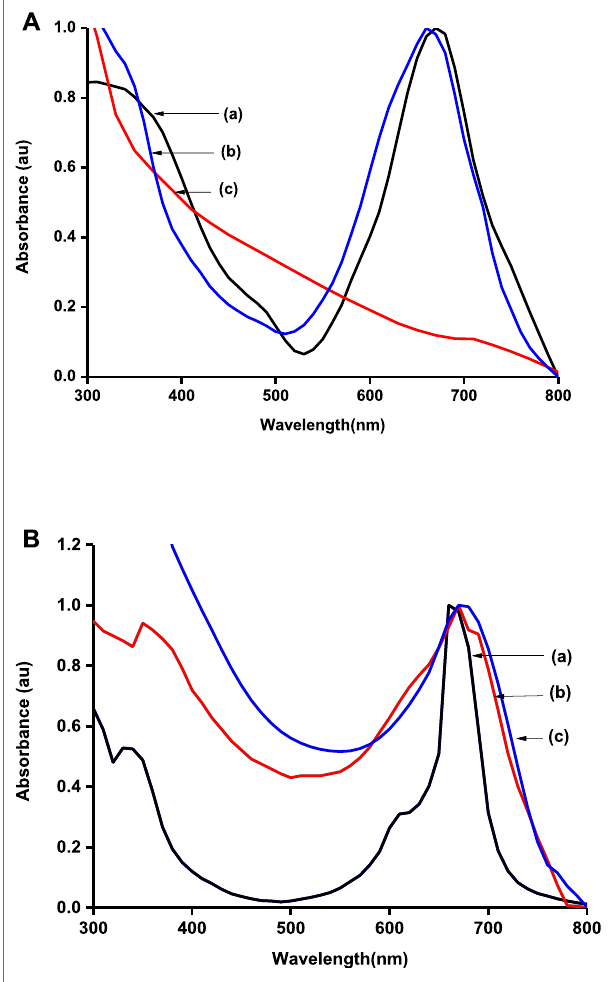
FIGURE 2 | Normalized UV/Vis spectra of electrode modi fi ers: (A) CoTAPc (a), CoTAPc-GONS (b), and GONS (c); (B) CoTCPc (a), poly- CoTCPc-CoTAPc (b), and poly-CoTCPc-CoTAPc-GONS (c) in DMSO.